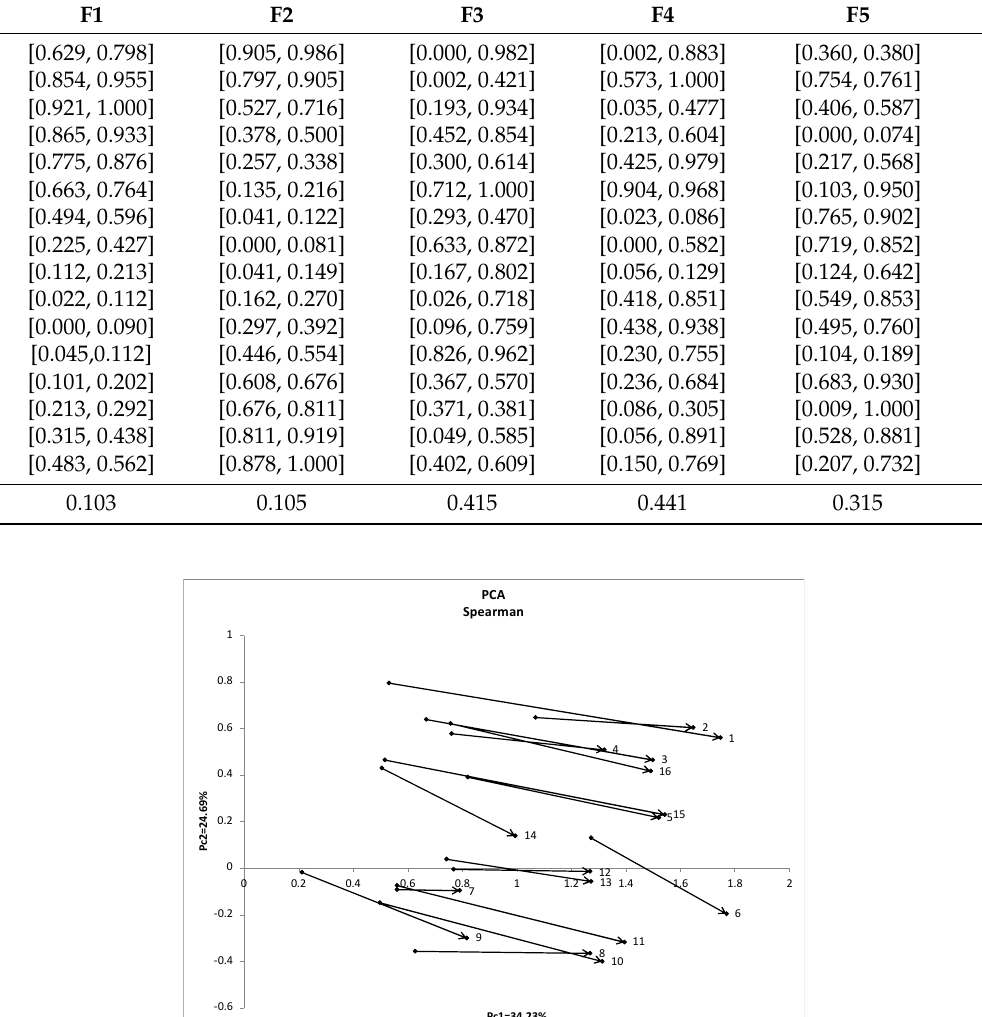
Figure 6. PCA result for oval artificial data. Figure 7 is the dendrogram based on the compactness for the first two features. It is clear that each cluster grows up along the oval structure of Figure 5. Our HCC generates eight comparably sized rectangles along the oval structure, then generates four rectangles, and so on. On the other hand, Figure 8 is the dendrogram for the given five features. We can also recognize the fact that each cluster grows up again along the oval structure of Figure 5 in spite of the addition of three useless features.